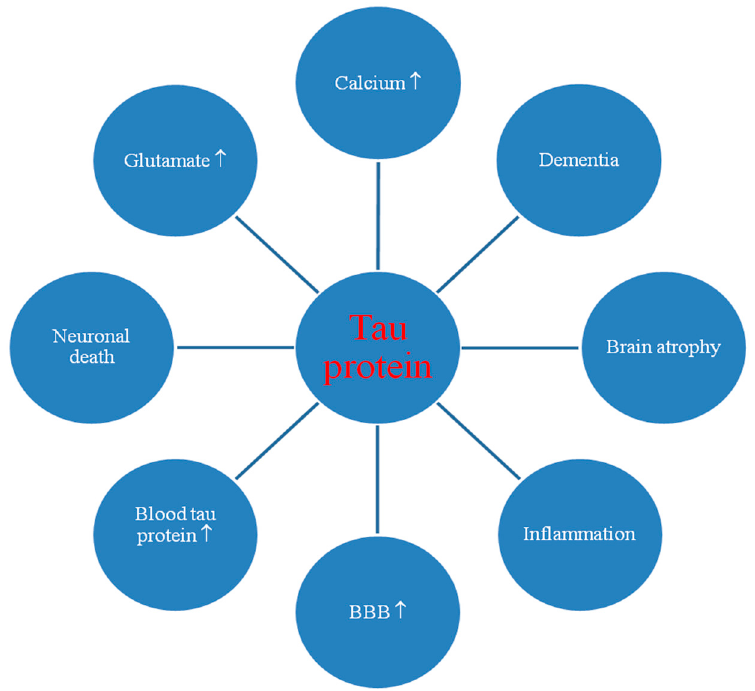
Figure 2. Potential pathological role of tau protein during ischemia-reperfusion brain injury. BBB: blood-brain barrier. ↑ : increase.